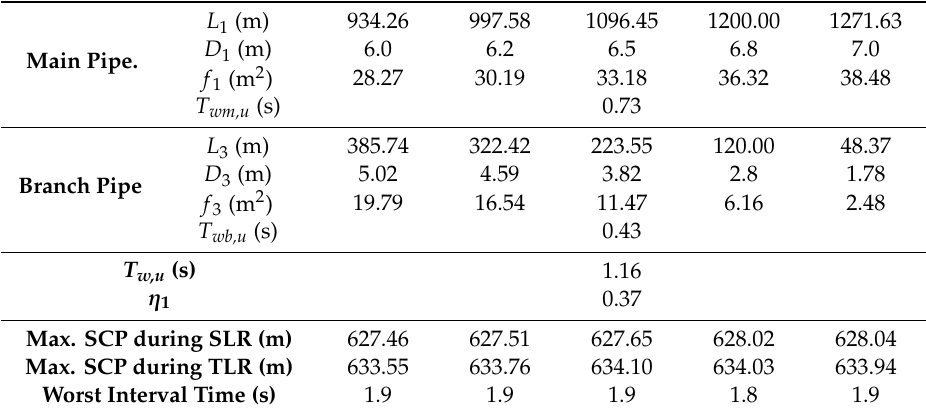
Table 5. Conduits parameters and corresponding results for Scenario